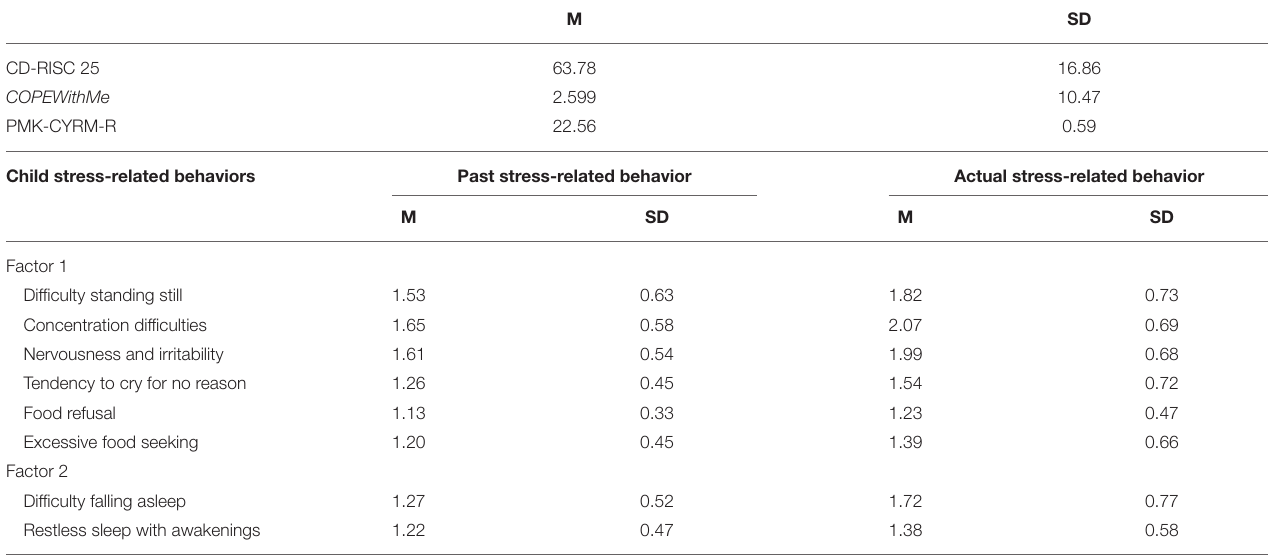
TABLE 2 | Descriptive statistics of the included